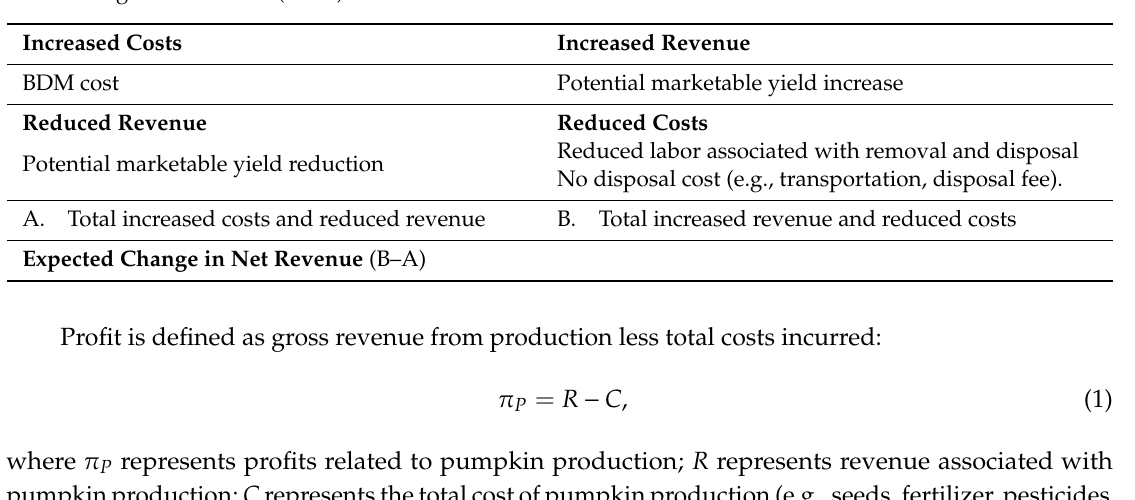
Table 1. Components of a partial budget comparing the use of polyethylene (PE) mulch and biodegradable mulch